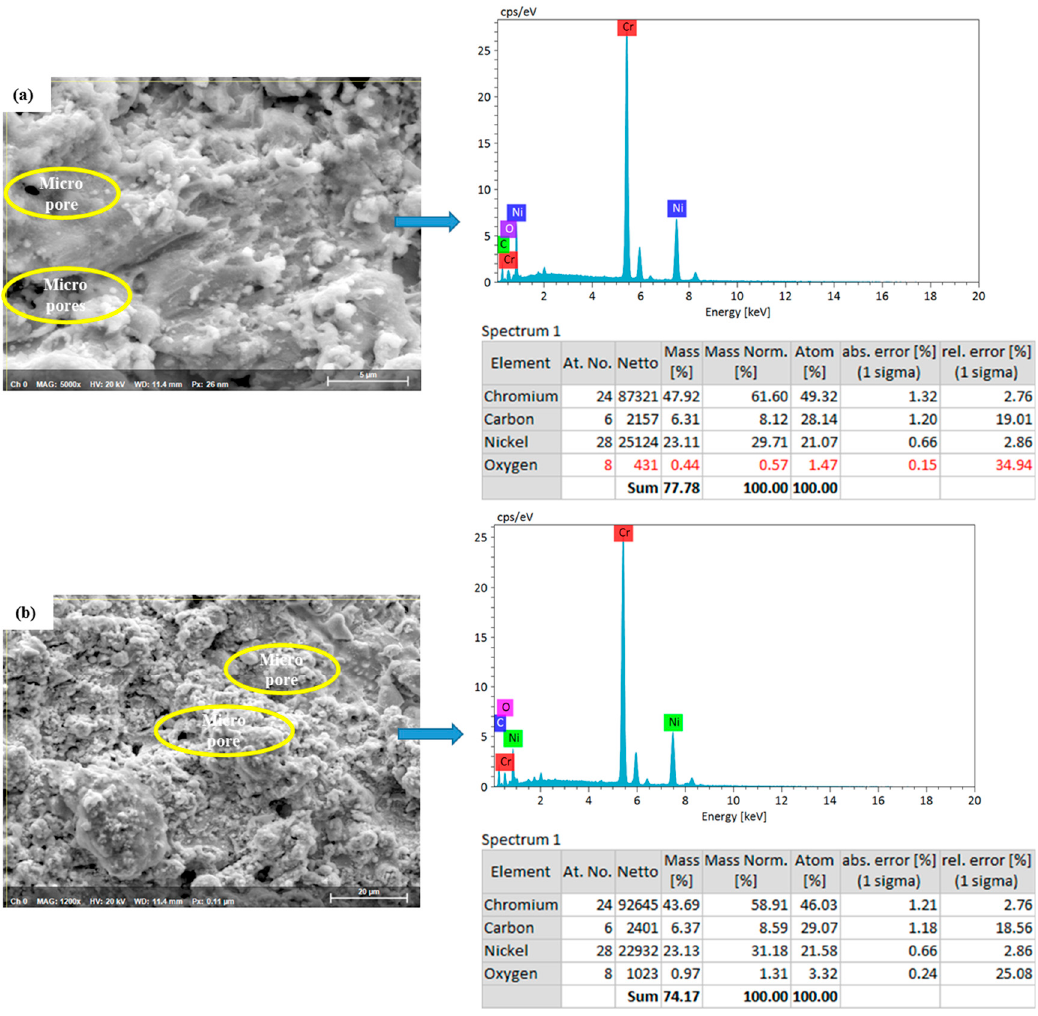
Figure 13. Surface morphology and EDS spectrum of Cr 3 C 2 –25NiCr coating that is ( a ) Ni ‐ rich and ( b ) O 2 ‐ rich after electrochemical erosion ‐ corrosion in 0.1 M NaCl solution at two different magnifications.